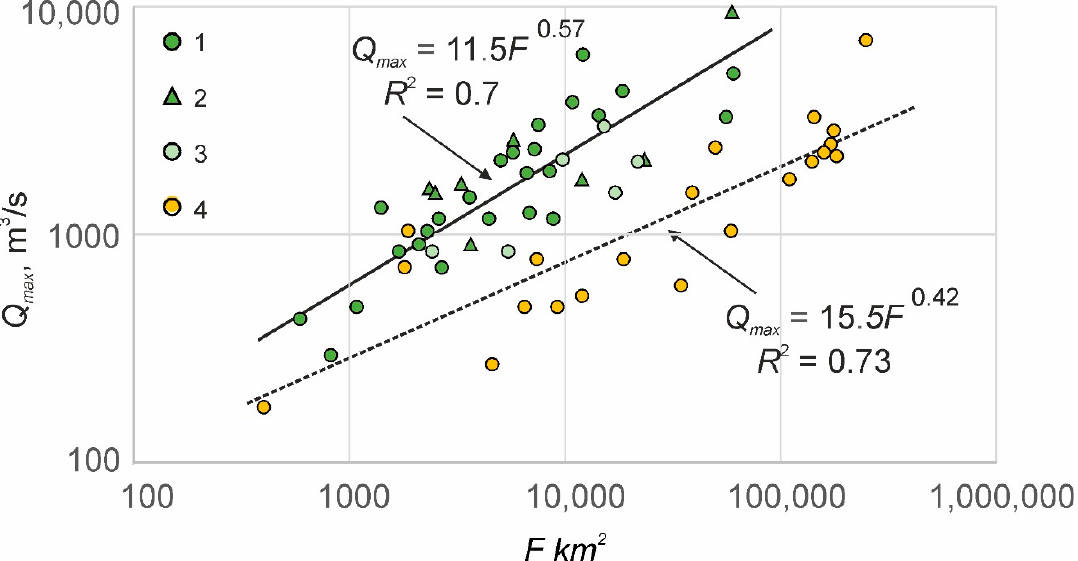
Figure 12. Regional relationships between maximum flood discharges Q max calculated with